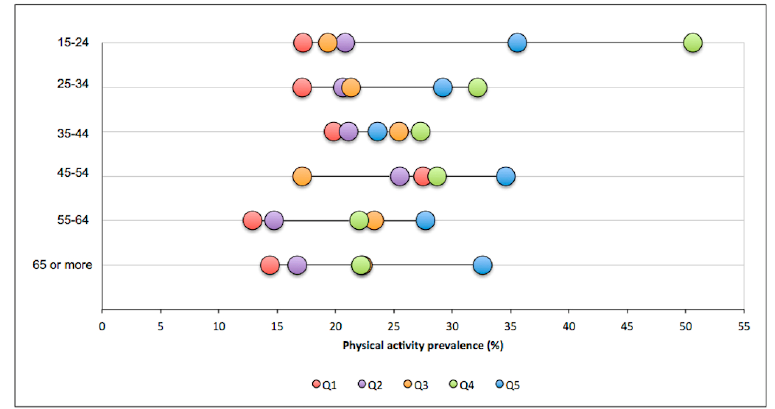
Figure 3. Differences in adherence to the PA recommendation guidelines in Uruguay according to socioeconomic status and age group. Q1: Quintile 1 (poorest); Q2: Quintile 2; Q3: Quintile 3; Q4: Quintile 4; Q5: Quintile 5 (wealthiest).